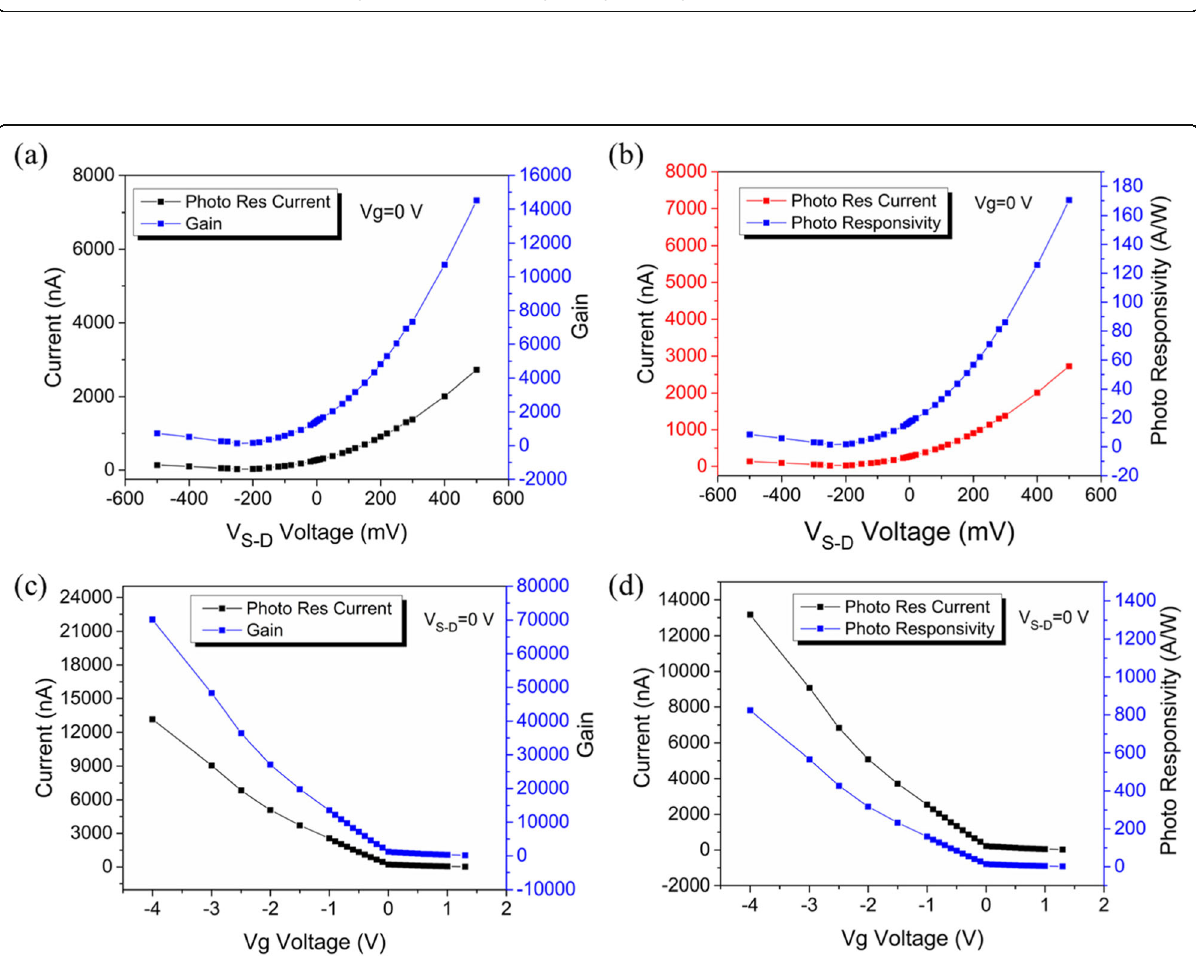
Fig. 4 Photoresponsivity dependence on the biased source-drain voltage and gate voltage. a and b reveal the source-drain voltage dependence of photoresponsivity and gain, respectively, c and d show the back-gate voltage dependence of photoresponsivity and gain,